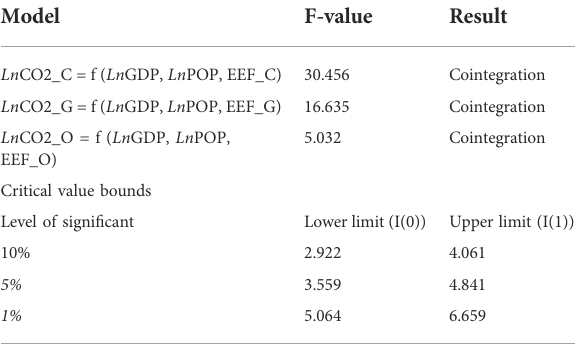
TABLE 9 Results for the bounds tests of all three models.